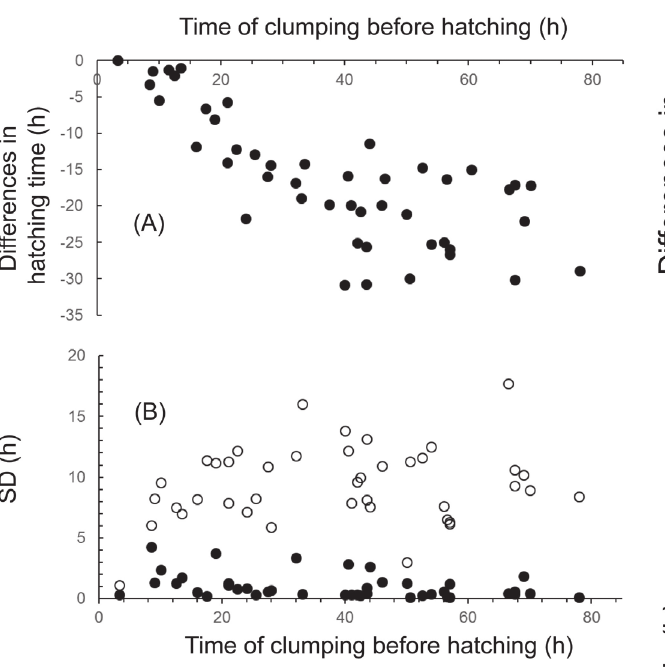
Fig. 9. The effect of the time of clumping of Locusta migratoria sepa- rated eggs on the hatching time. The differences in mean hatching times between eggs clumped and those kept with distance from one another (controls) are plotted against the time of egg clump- ing gauged based on the mean hatching time for the control eggs ( A ). SDs of the mean hatching times for the clumped eggs (closed circles) and control eggs (open circles) are similarly plotted in ( B ). Each datum point is based on 17–20 eggs. Fig. 10. The effect of the time of pairing of Locusta migratoria sepa- rated eggs on the time of hatching. The differences in hatching time between the paired eggs and control eggs kept as separated eggs are plotted against the time of egg clumping gauged based on the mean hatching time for the control eggs ( A ). Comparison of SDs of the mean hatching times ( B ) and the intervals of hatching in each pair ( C ) for the clumped eggs (closed circles) and the con- trol eggs (open circles). Each datum point is based on